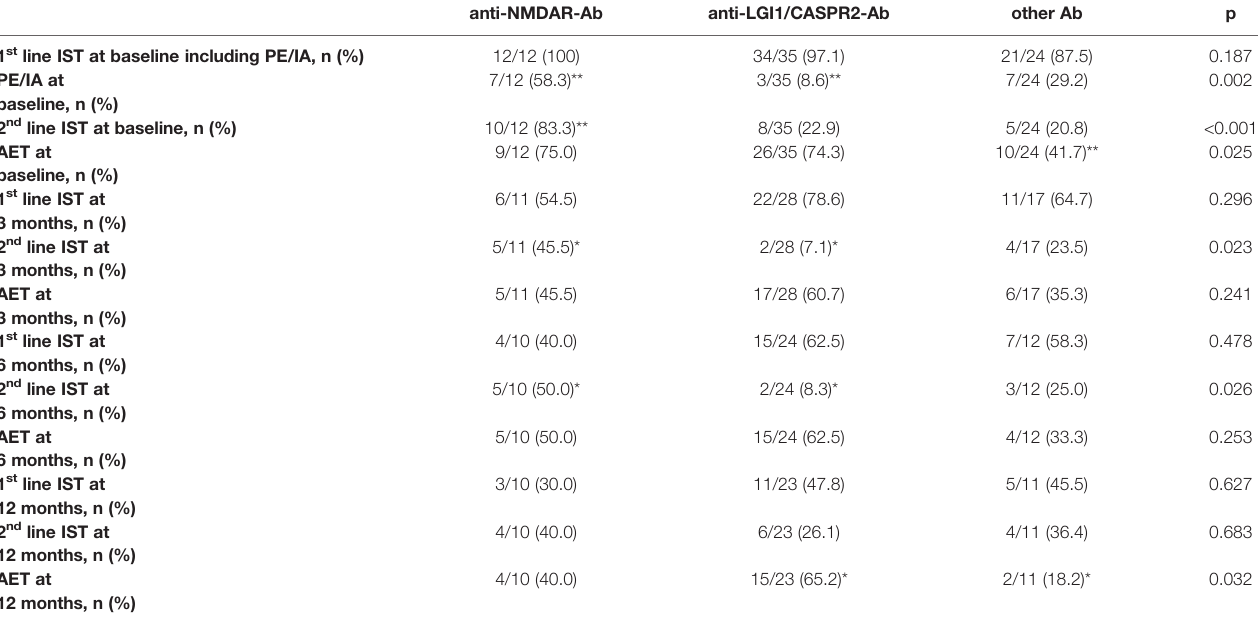
TABLE 2 | Immunosuppressive and antiepileptic treatments applied in patients strati fi ed according to their antibody